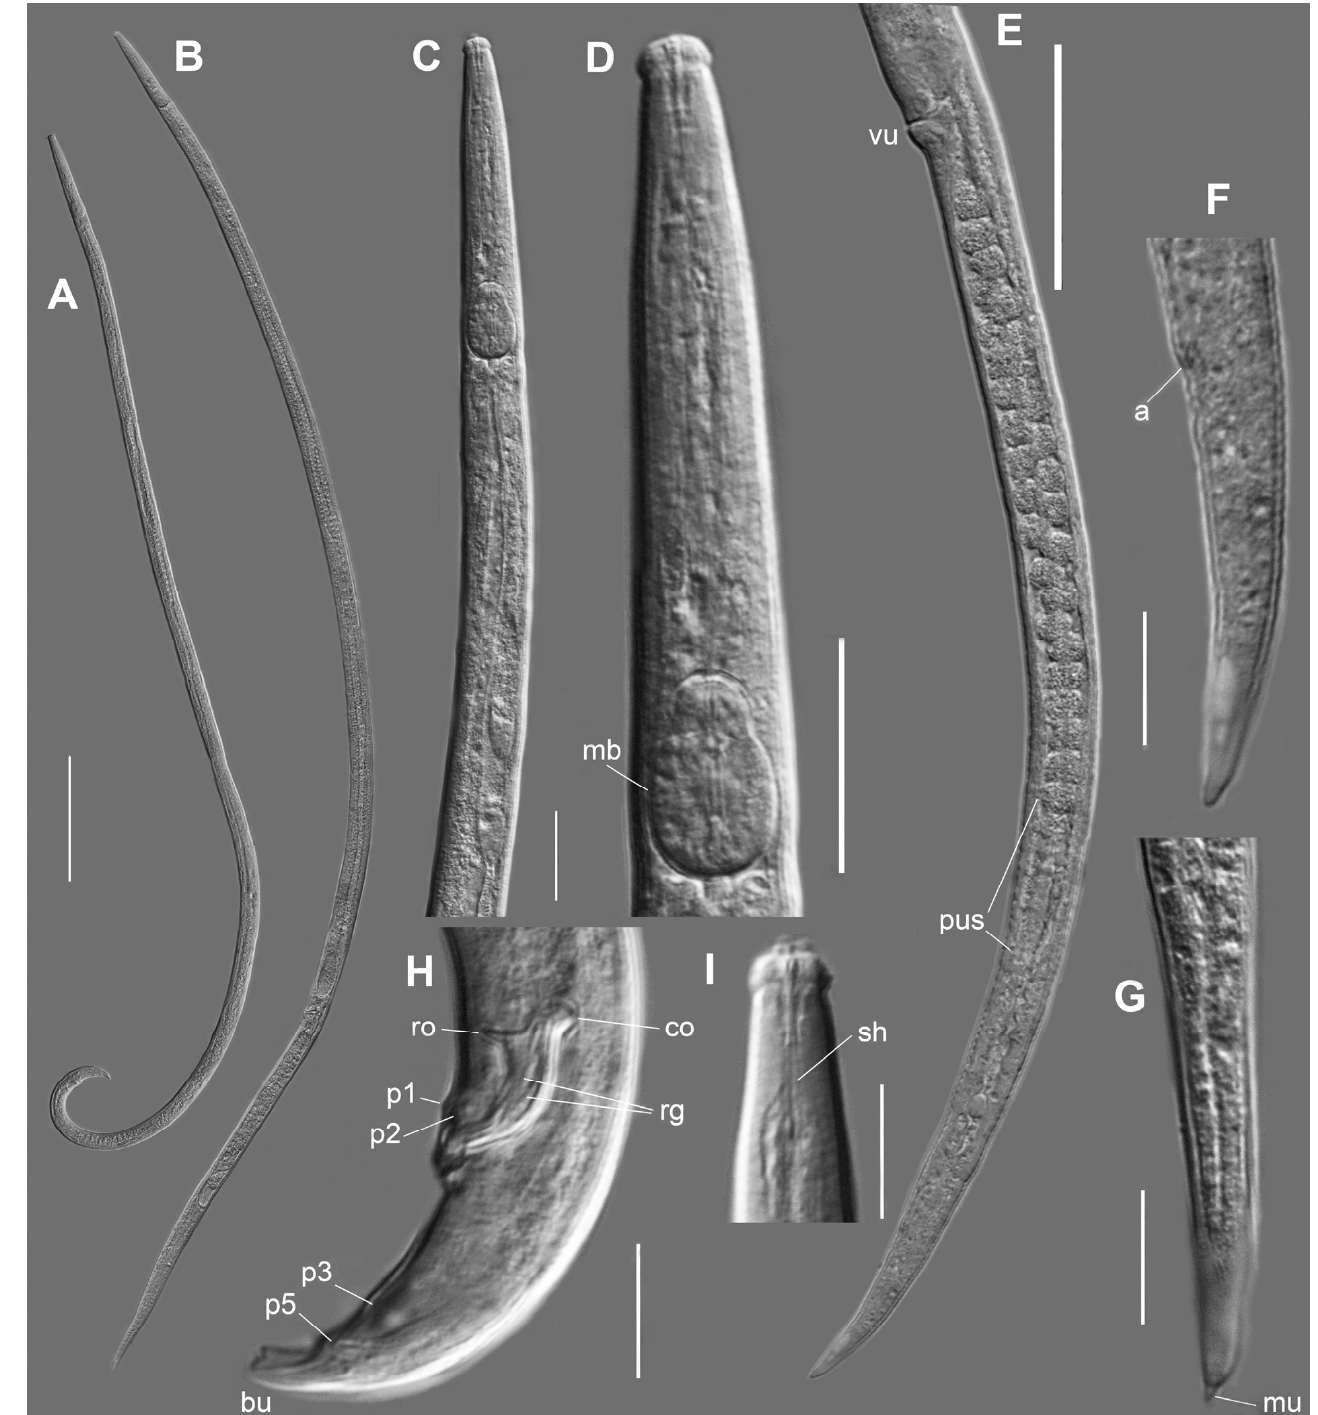
Figure 5. Bursaphelenchus michalskii , Dagestan. ( A )—male. ( B )—female. ( C , D )—female anterior end. ( E )—posterior body end of female. ( F , G )—female tails. ( H )—caudal part of male. ( I )—male lip region. Abbreviations: mu—mucron, vu—vulva, other abbreviations as in Figure 1. Scale—100 μ m for ( A , B ); 20 μ m for ( C , D ); 50 μ m for ( E ); 10 μ m for rest.